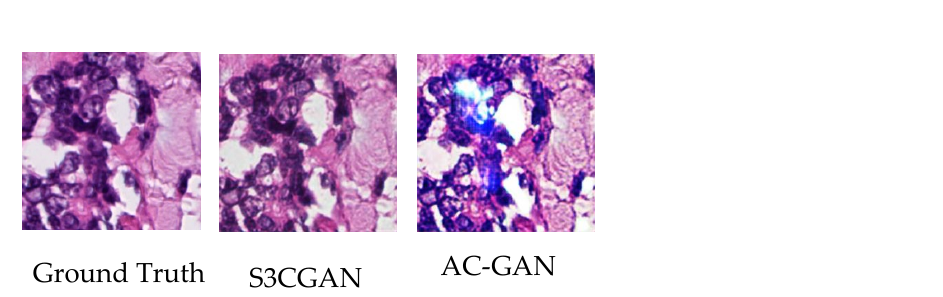
Figure 11. Comparison of the results obtained using the specialized color classifier and embedded classifier.